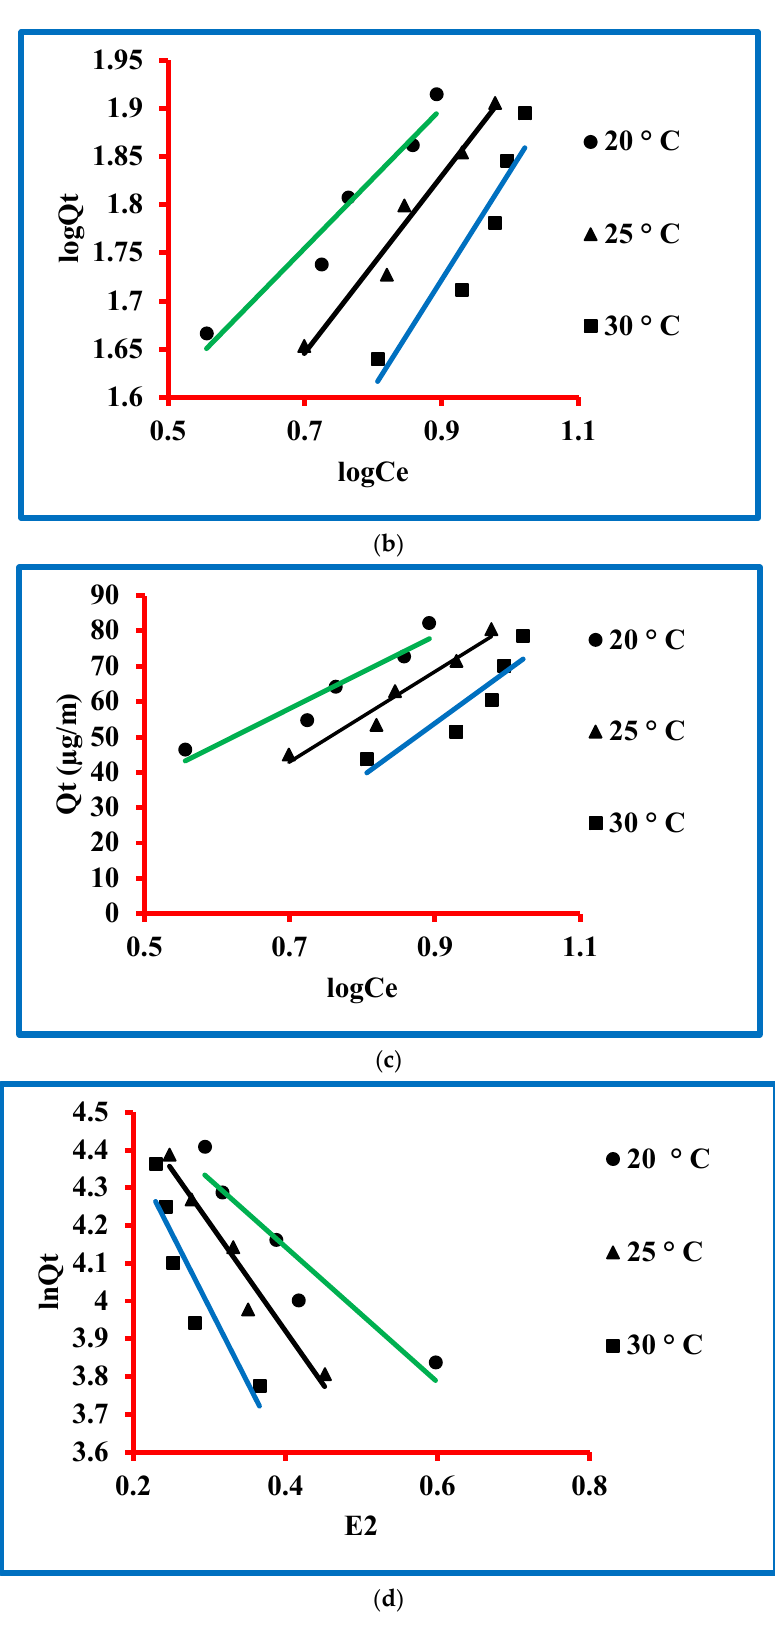
Figure 6. Models for triclosan: ( a ) Langmuir, ( b ) Freundlich, ( c ) Temkin and ( d ) Dubinin–Radush- kevich.